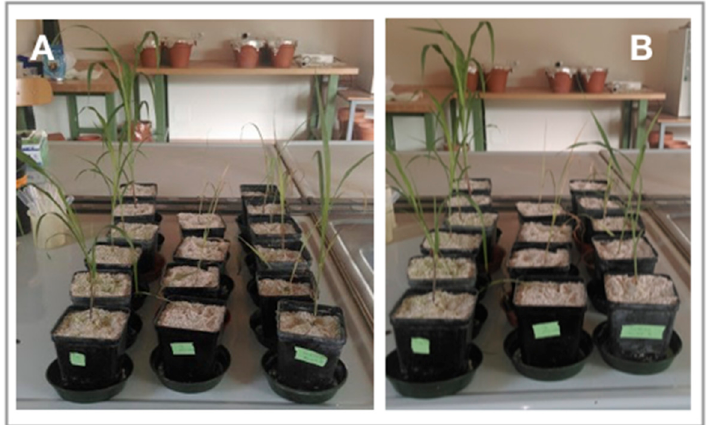
Figure 7. E ff ects of the strains P. migulae SVB3R3 ( A ) and P. brassicacearum SVB6R1 ( B ) on the growth of plants exposed to salt stress. From left to right: control plants not exposed to NaCl, plants fed with 150 mM NaCl and endophyte-inoculated plants fed with 150 mM NaCl.